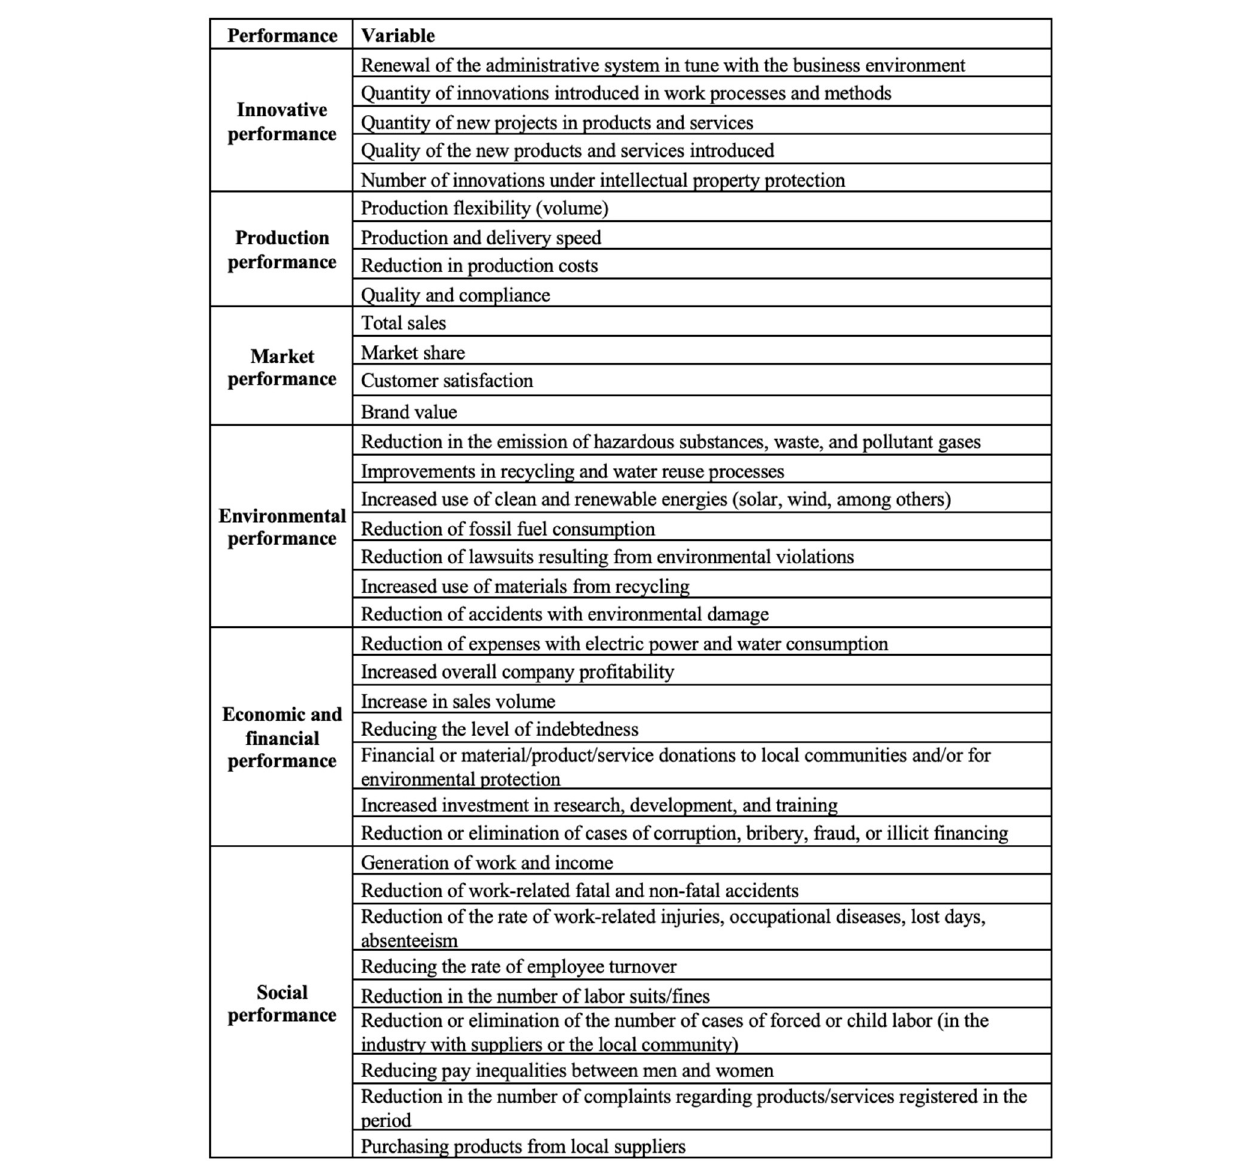
FIGURE 1 | Proposal of Gunday et al. (2011) and Global Reporting Initiative (2016).